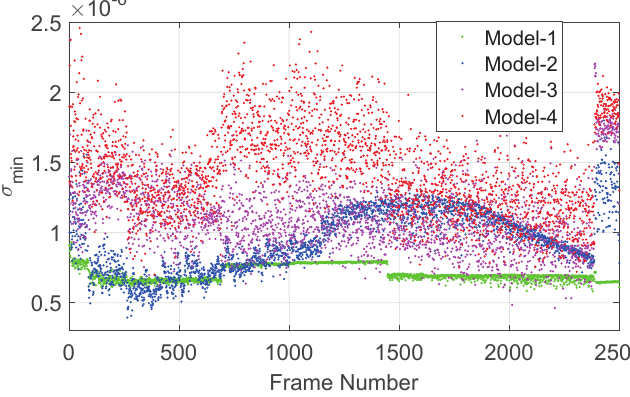
Figure 3. Observability analysis of the